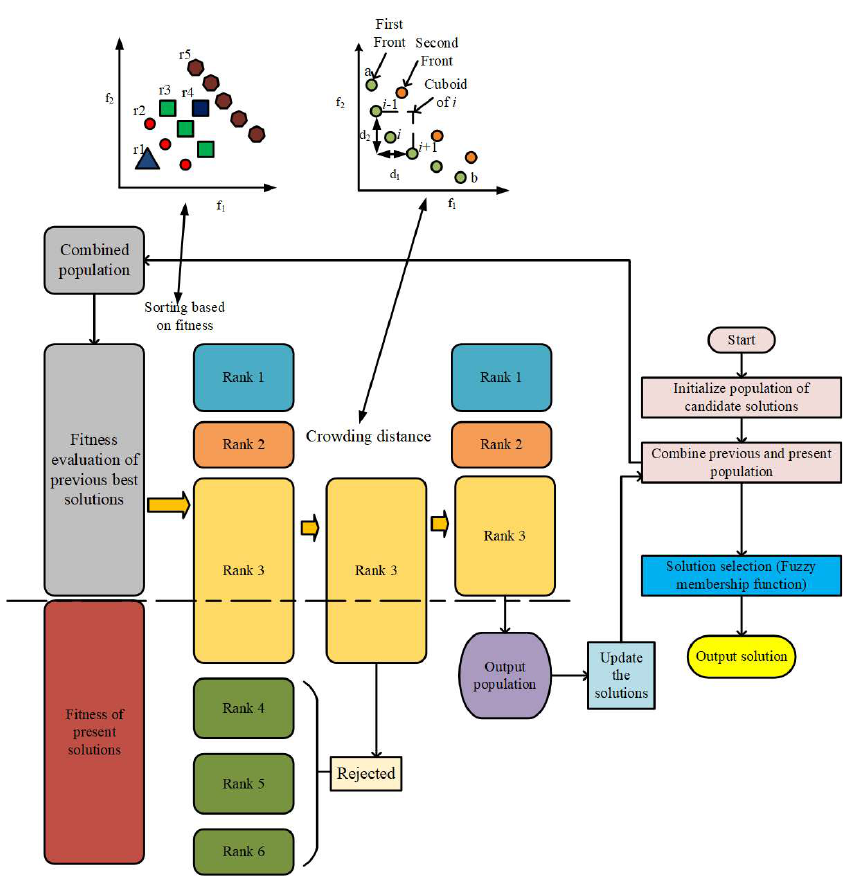
Fig. 5. Schematic representation of non-dominated sorting based algorithm  Non-domination rank  Crowding